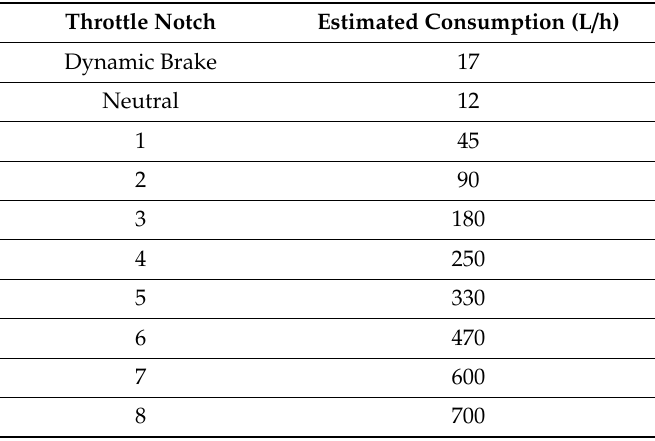
Table 2. Estimated fuel consumption by throttle notch